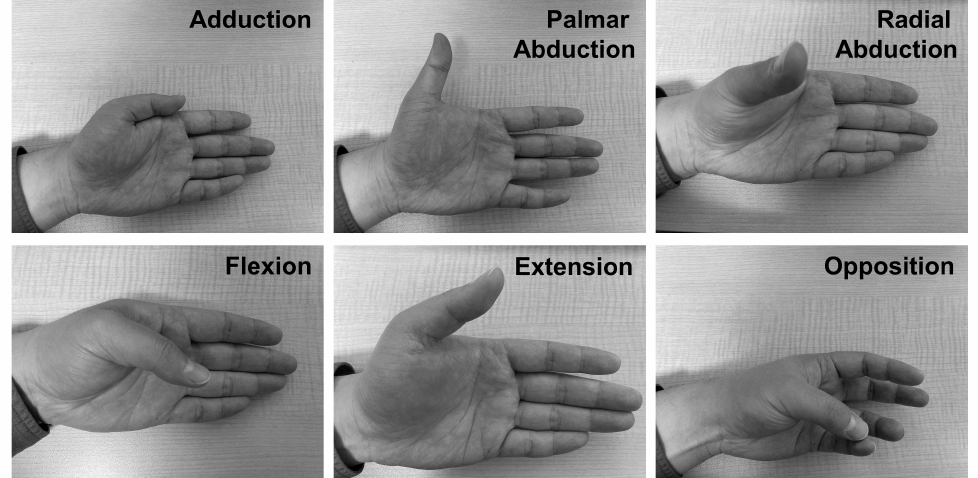
Figure 2. The thumb movements: Adduction, Palmar Abduction, Radial Abduction, Flexion, Exten- sion, and